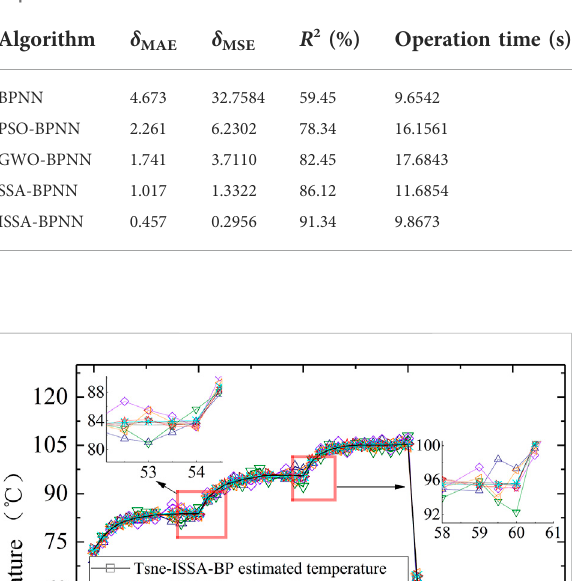
TABLE 5 Cable joint core temperature inversion performance after dimension